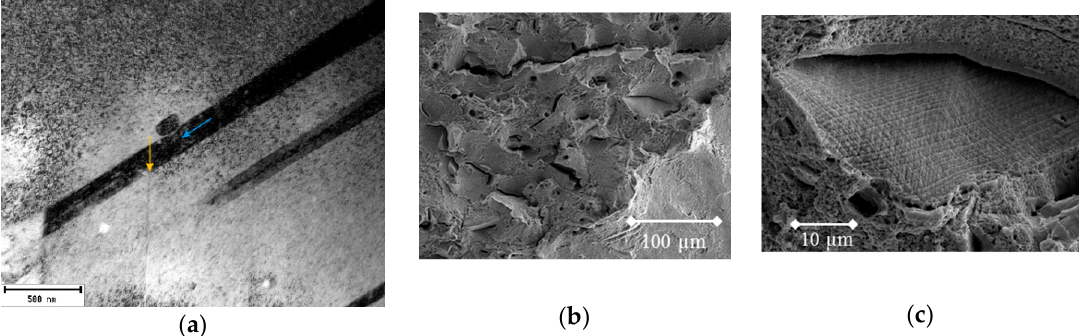
Figure 16. The 18Cr-10Ni-Ti steel in-service WWER irradiated to 5.2 dpa after tensile test at RT: ( a ) microstructure below fracture showing twins (yellow arrow) and strain martensite needles (blue arrow) [6]; Copyright 2017 by The Minerals, Metals & Materials Society. Used with permission; ( b ) fracture surface showing mix of dimples, secondary cracks and TG facets and ( c ) detail of the facet. In the case of the 20%CW A316 irradiated at intermediate T (385 °C) contained ~3–8% void